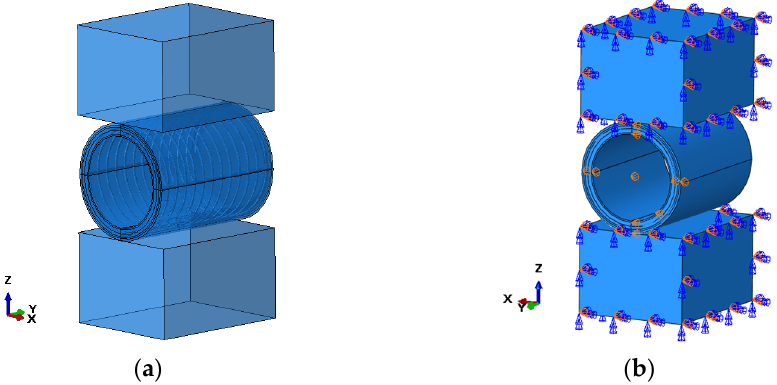
Figure 9. FE model for the crush simulation: ( a ) general configuration; ( b ) boundary condition.